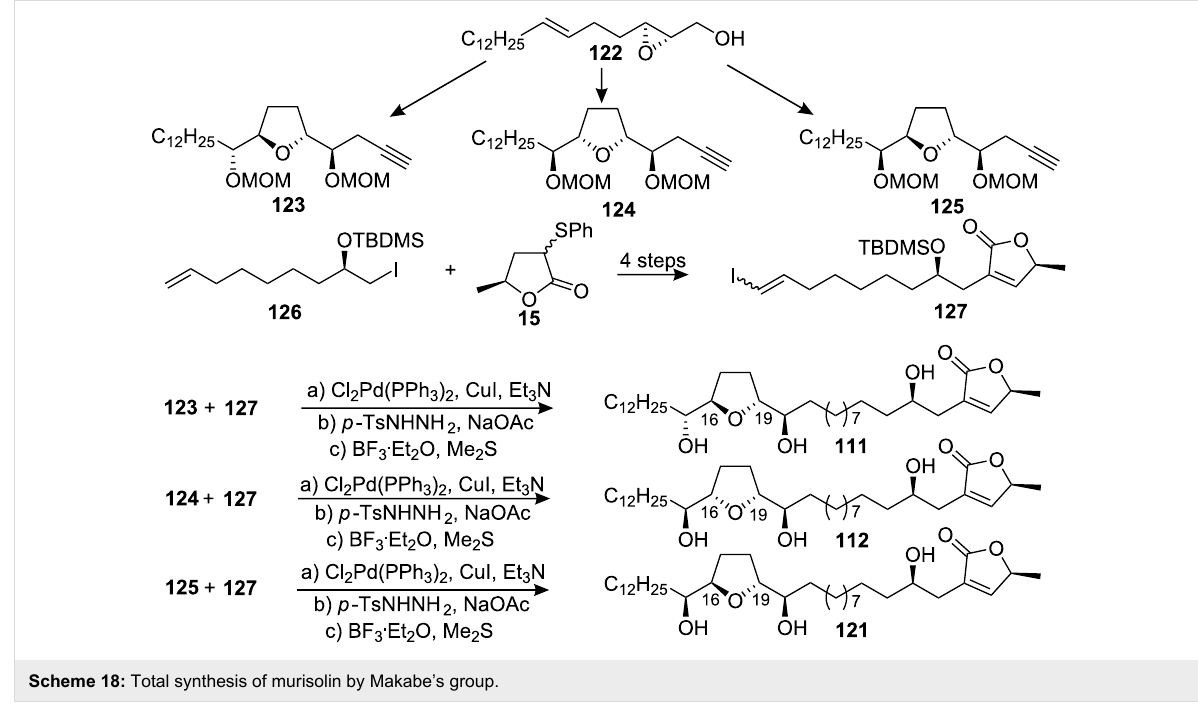
Scheme 18: Total synthesis of murisolin by Makabe’s group.